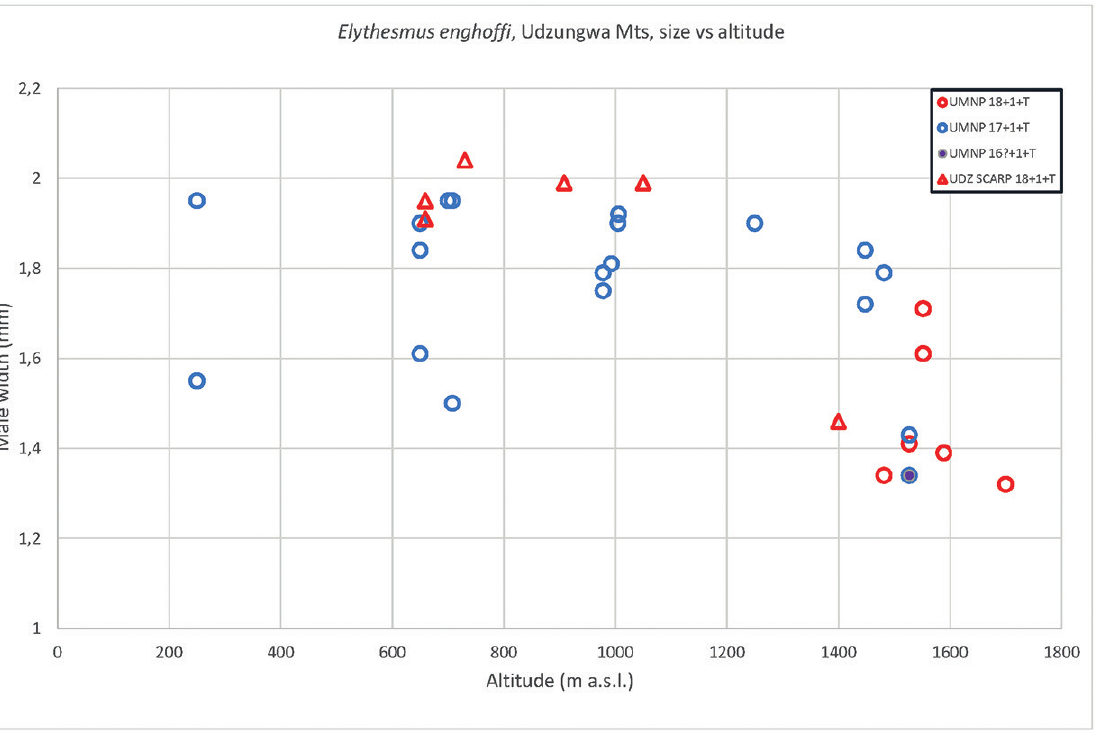
Fig. 17. Elythemus enghoffi Hoffman, 1978, variation in body width and number of body rings of males from the Udzungwa Mts. Abbreviations: UDZ SCARP = Udzungwa Scarp Catchment Forest Reserve; UMNP = Udzungwa Mts National